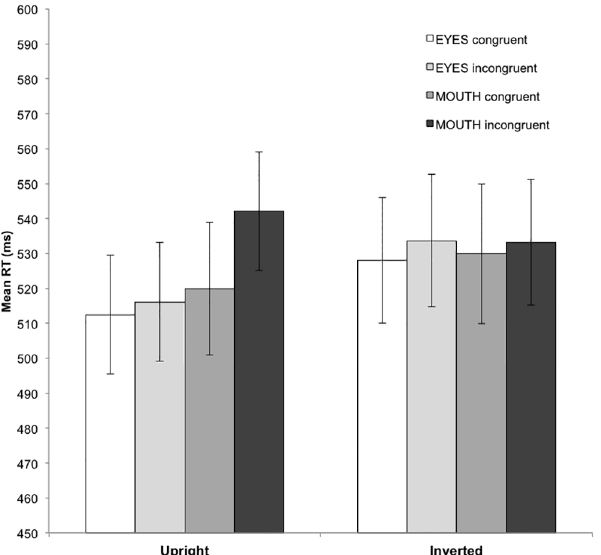
Fig 1. Behavioral results. Mean reaction times separately for upright and inverted faces in each experimental condition: open eyes congruent (white bar), open eyes incongruent (light grey bar), open mouth congruent (dark grey bar), and open mouth incongruent (black bar). Error bars represent standard errors.